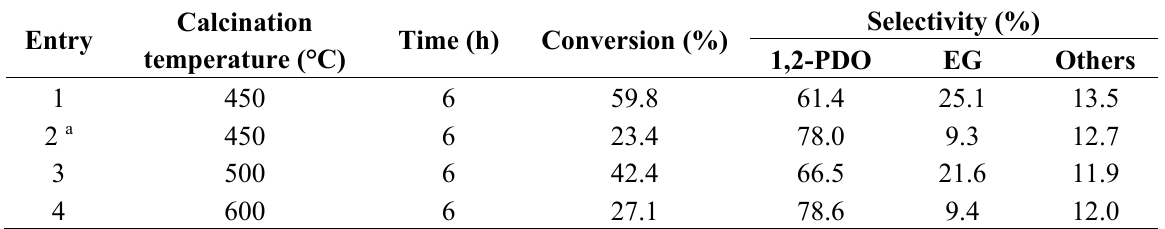
Table 3. Effect of calcination temperature on the catalytic performance of 17.5% Ni/Al 2 O 3 -T catalysts.